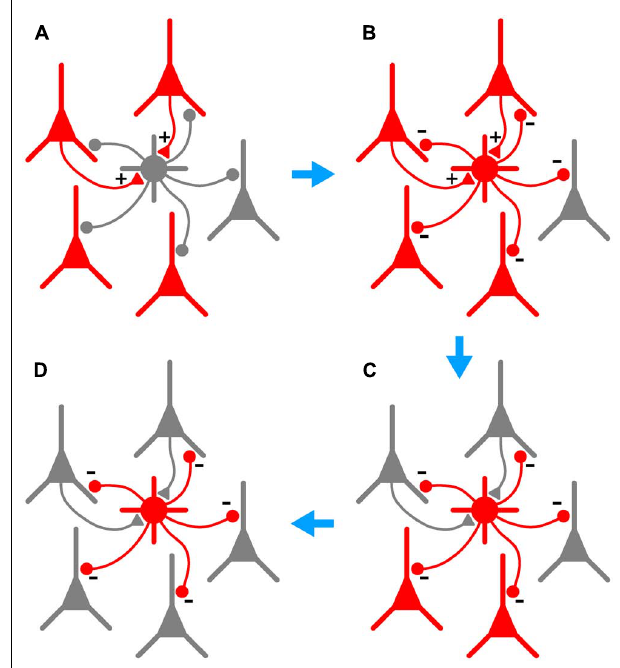
FIGURE 7 | Hypothesized series of steps by which BF could lead to autonomous and generalized inhibition in response to cortical hyperexcitability. (A) , A population of pyramidal cells becomes hyperexcitable (red). A subset of these pyramidal cells synaptically excites a nearby NG or FS interneuron ( + symbols on gray cell at center). (B) , As a result of this excitation, the interneuron begins to fire repeatedly (gray cell becomes red), synaptically inhibiting a large number of pyramidal cells in its vicinity ( − symbols). (C) ,This inhibition eventually silences a subset of pyramidal cells, including those that are synaptically exciting the interneuron (upper two pyramidal cells become gray). However, BF ensures that the interneuron keeps firing after the presynaptic pyramidal cells fall silent, allowing the interneuron to continue inhibiting other nearby pyramidal cells that do not excite it. (D) , In due course all hyperexcitable pyramidal cells near the interneuron are silenced (all become gray). BF in the interneuron eventually ceases (not shown). Note that the scheme depicted here would only work in the cerebral cortex; hippocampal NG cells do not provide feedback inhibition to pyramidal cells (Price etal.,